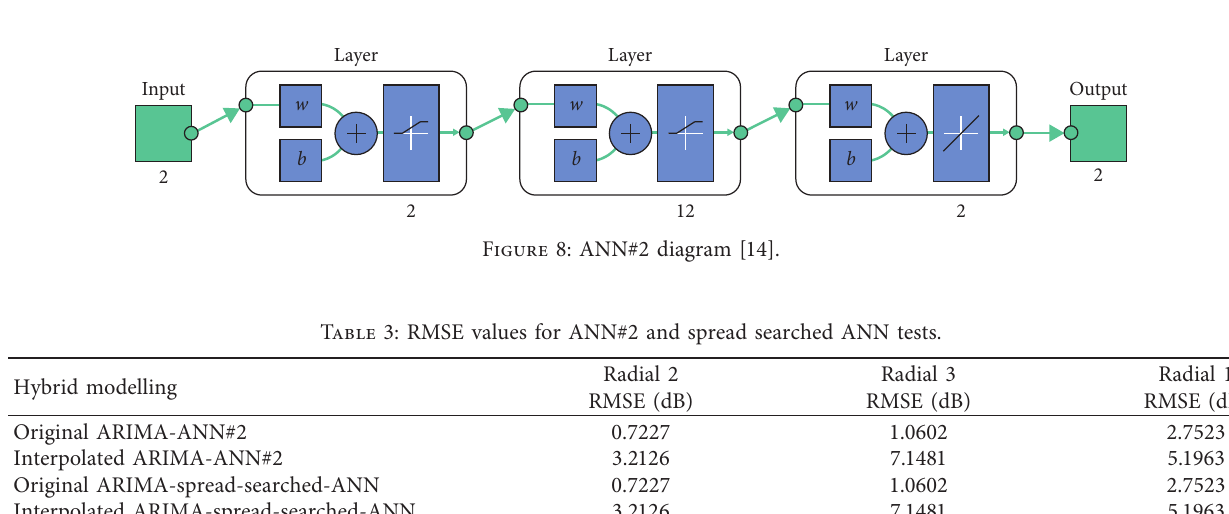
Figure 7: Graphs of ANN #2 and spread searched fittings for original radial 2 (a); original radial 3 (b); original radial 1 (c); interpolated radial 2 (d); interpolated radial 3 (e);and interpolated radial 1 (f).